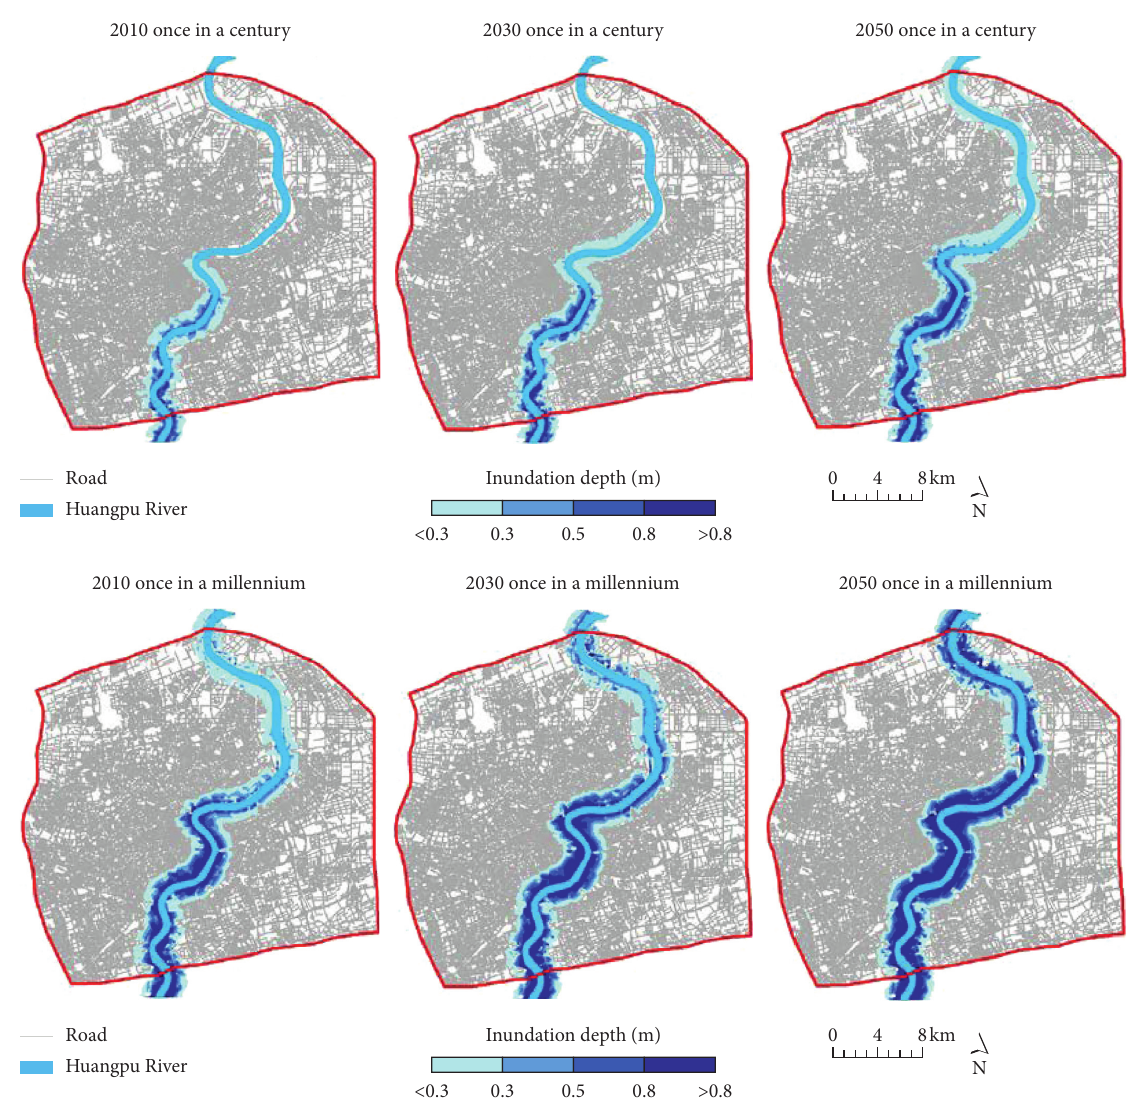
Figure 3: Inundation extents and depths for flood scenarios in the city center of